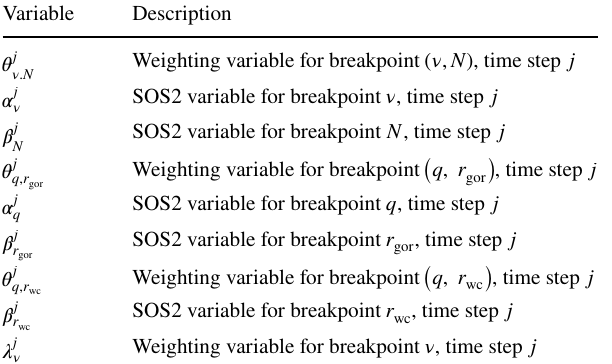
Table 11 Auxiliary variables used in the MILP formulation